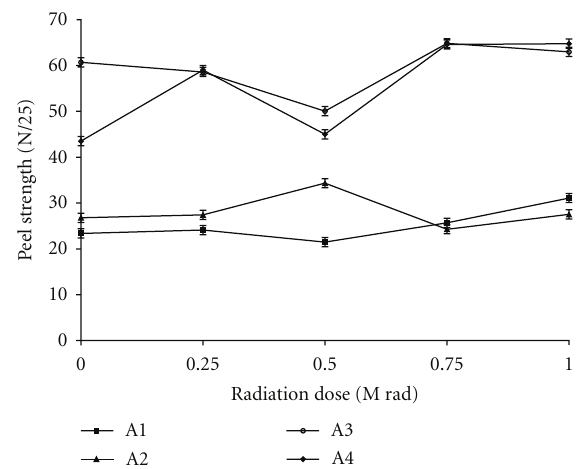
Figure 2: E ff ect of radiation on adhesion force between EPDM and polyester